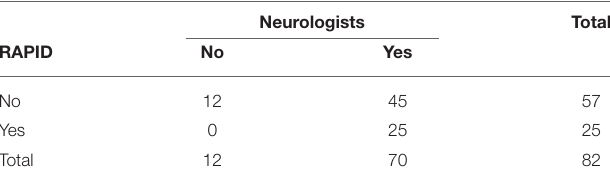
RAPID software, and 0.947 (95% CI , 0.917–0.966, F = 18.5, df 81) TABLE 4 | Number of supratentorial automated detected diffusion weighted imaging (DWI) lesions in comparison to the visual detected ones by the trained